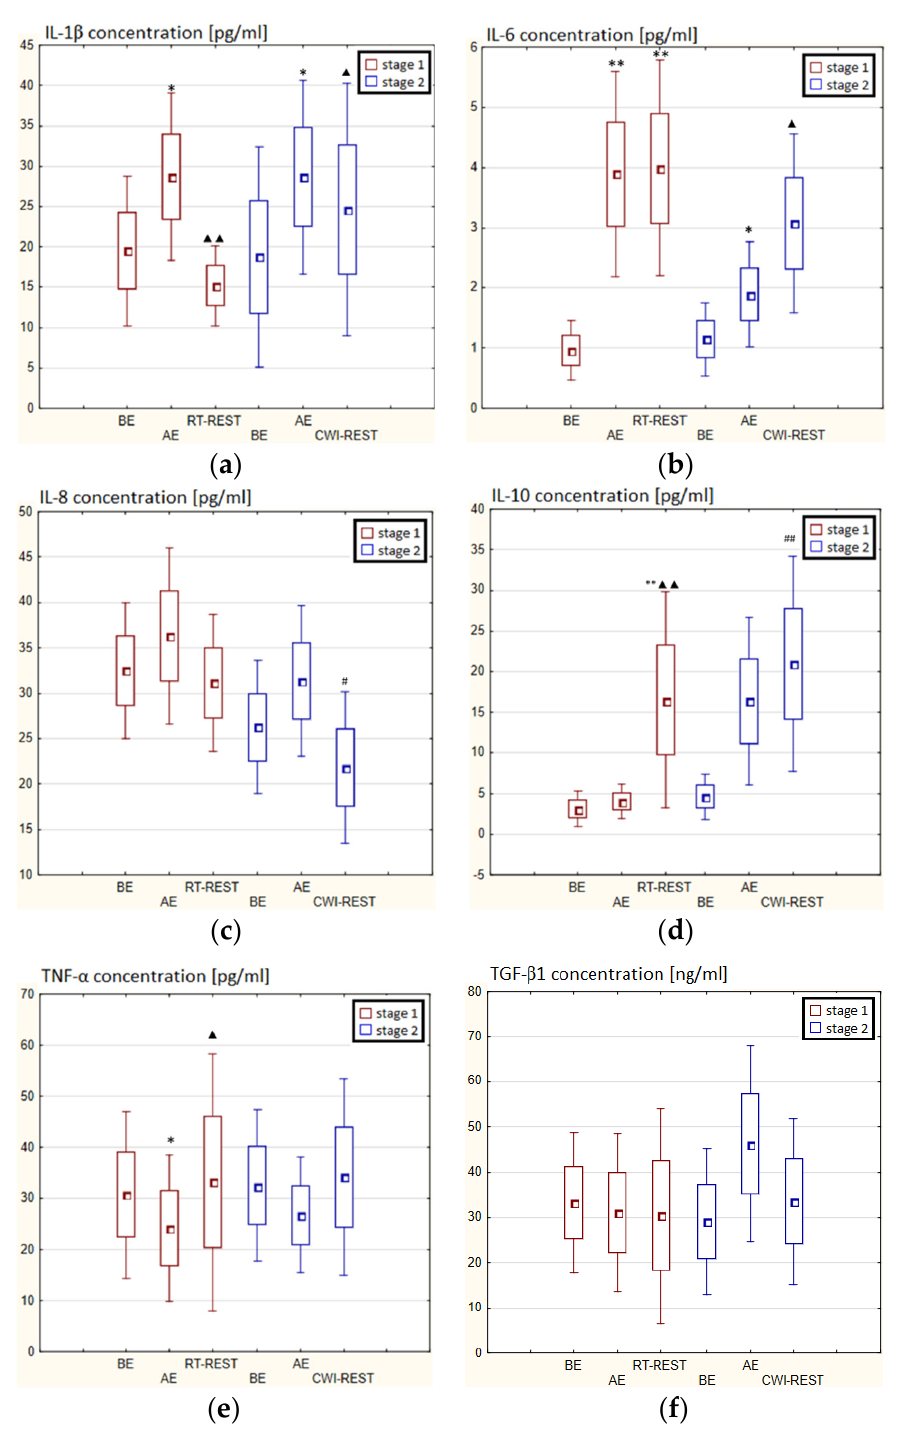
Figure 8. The concentration of selected cytokines in blood serum of novices ( n = 23) in Experiment I: ( a ) IL-1 β concentration; ( b ) IL-6 concentration; ( c ) IL-8 concentration; ( d ) IL-10 concentration; ( e ) TNF- α concentration; ( f ) TGF- β 1 concentration. Data are presented as the mean values ± SD. IL-1 β —interleukin 1 β , IL-6—interleukin 6, IL-8—interleukin 8, IL-10—interleukin 10, TNF- α —tumor necrosis fac-